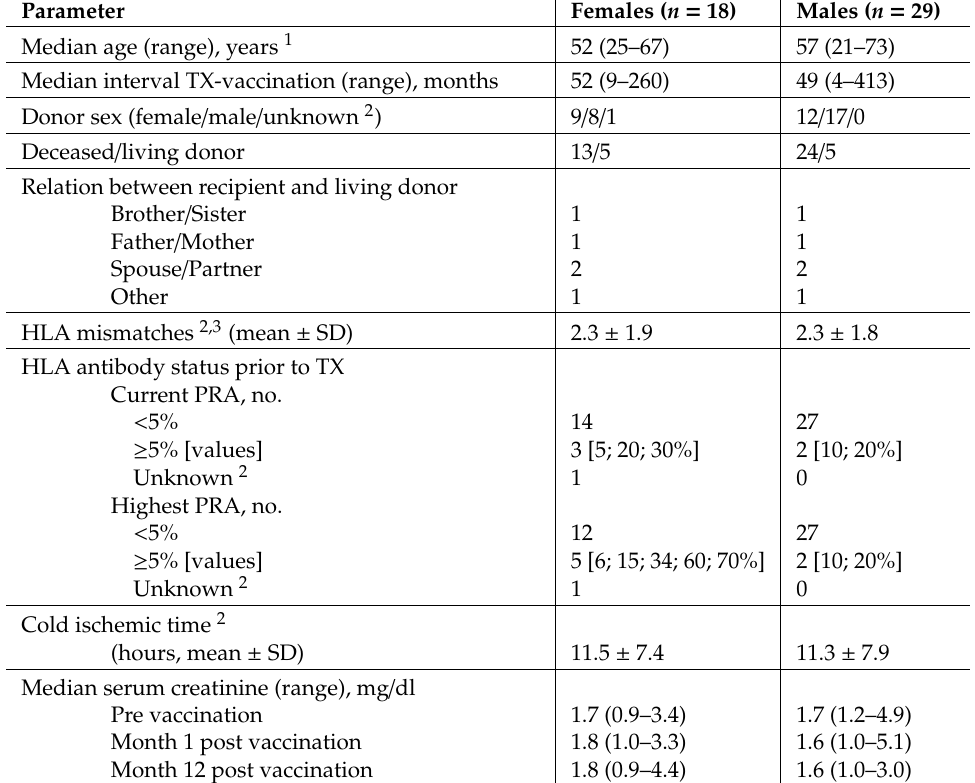
Table 1. Characteristics of 47 kidney transplant recipients at the time of vaccination with